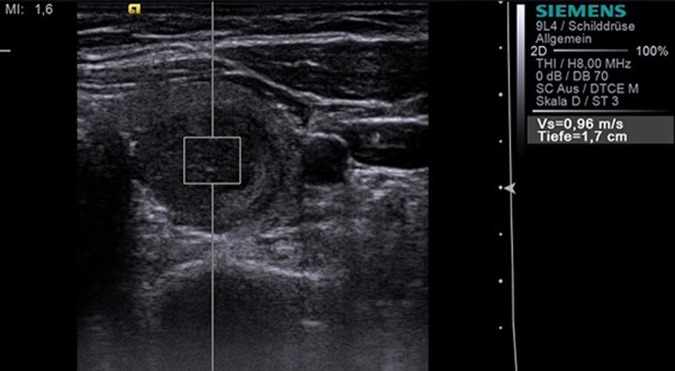
Acoustic Radiation Force Impulse Imaging (S2000, 9L4 probe at 9MHz) with the ROI placed within a hypoechoic thyroid nodule in the left thyroid lobe measuring a velocity of 0.96 m/s.Histology revealed benign nodule.